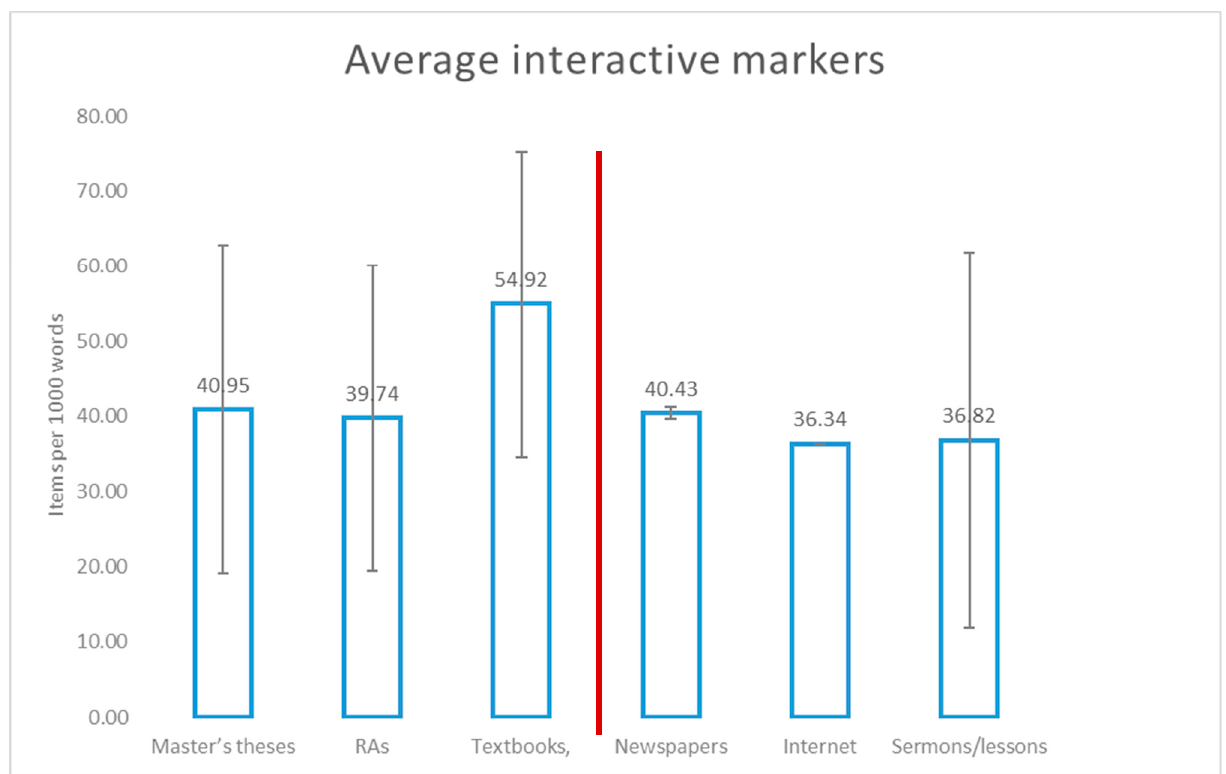
Figure 5. Interactive markers. Items per 1000 words (on average). Red line divides the academic from non-academic texts.